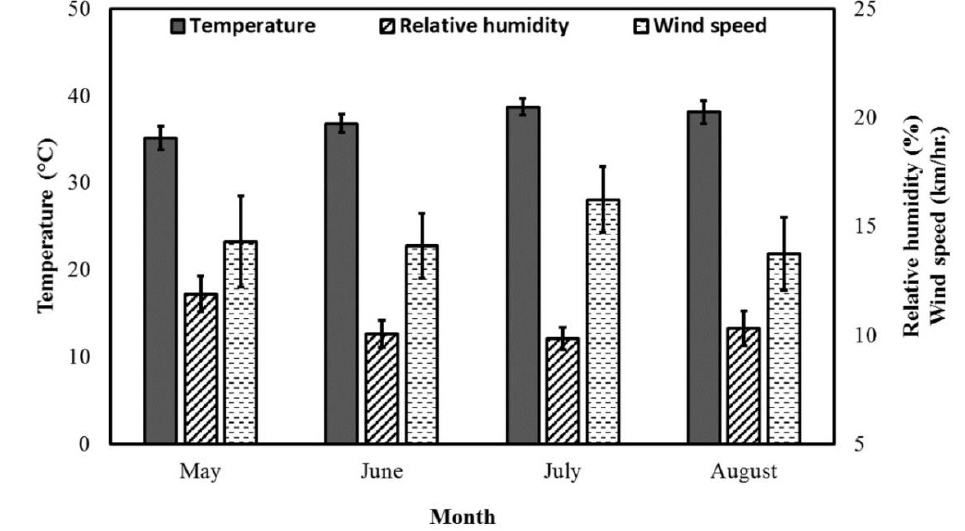
Figure 2. Monthly average values of weather factors during the Acacia gerrardii flow (May-August) in Central Arabia for the 2017 and 2018 seasons .